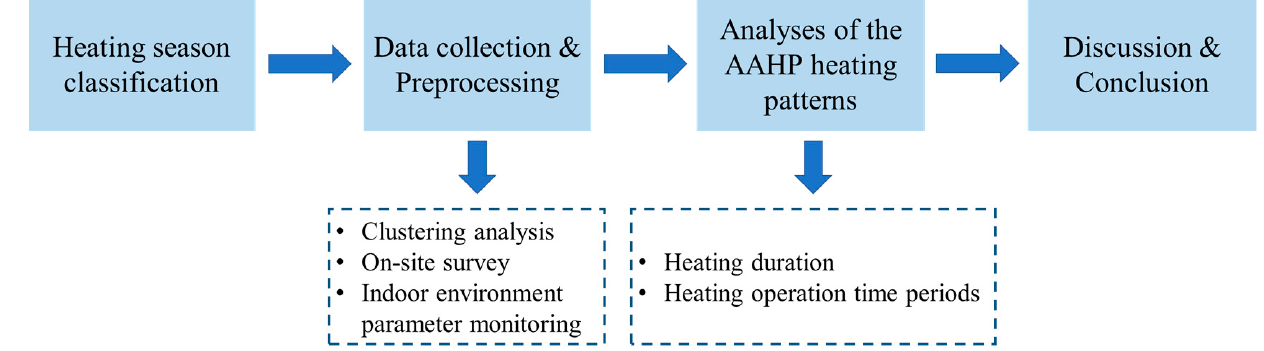
Figure 1. The framework of the research.